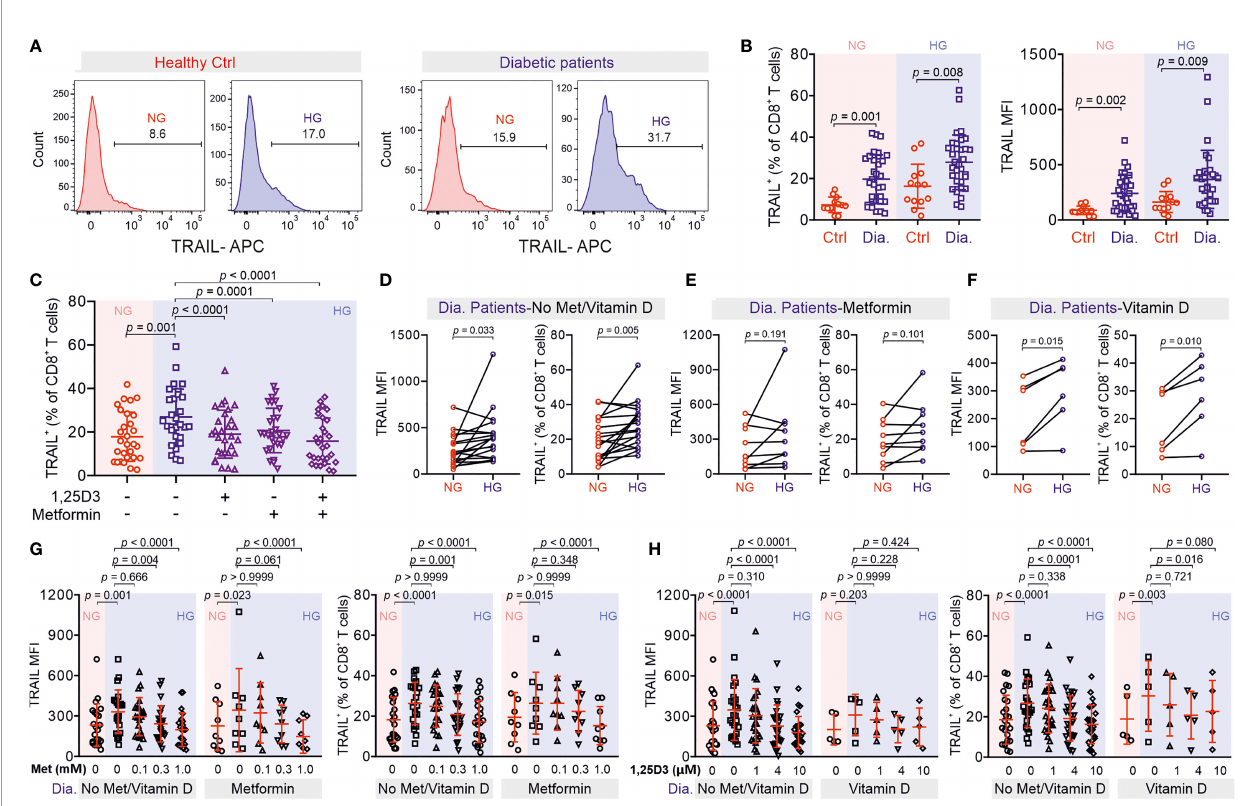
FIGURE 6 | Treatment of metformin and vitamin D decreases TRAIL-expression in CTLs from diabetic patients. (A, B) TRAIL expression in CTLs from control and diabetic patients. PBMCs isolated from healthy individuals or diabetic patients were stimulated with CD3/CD28 beads in NG (5.6 mM, pink shade) or HG (25 mM, blue shade) medium for 3 days. Then the samples were stained with CD3, CD8 and TRAIL and analyzed by fl ow cytometry (Ctrl, n = 13 from thirteen independent experiments; diabetic patients, n = 33 from twenty-four independent experiments). One representative donor from either group is shown in (A, C) Metformin and vitamin D diminish enhanced TRAIL expression in diabetic CTLs. Diabetic CTLs from (B) were treated with met (300 µM) and/or 1,25D3 (4 µM) during bead- activation for 3 days (n = 29 from twenty-one independent experiments). (D – H) Diabetic patients from (B) were categorized into three groups based on whether metformin or vitamin D was taken. Data are represented as Mean ± SD and p values were assessed by two-tailed unpaired Student ’ s t test (B) , two-tailed paired Student ’ s t test (D – F) , one-way ANOVA (C) , or two-way ANOVA with Bonferroni ’ s multiple comparison test (G, H)